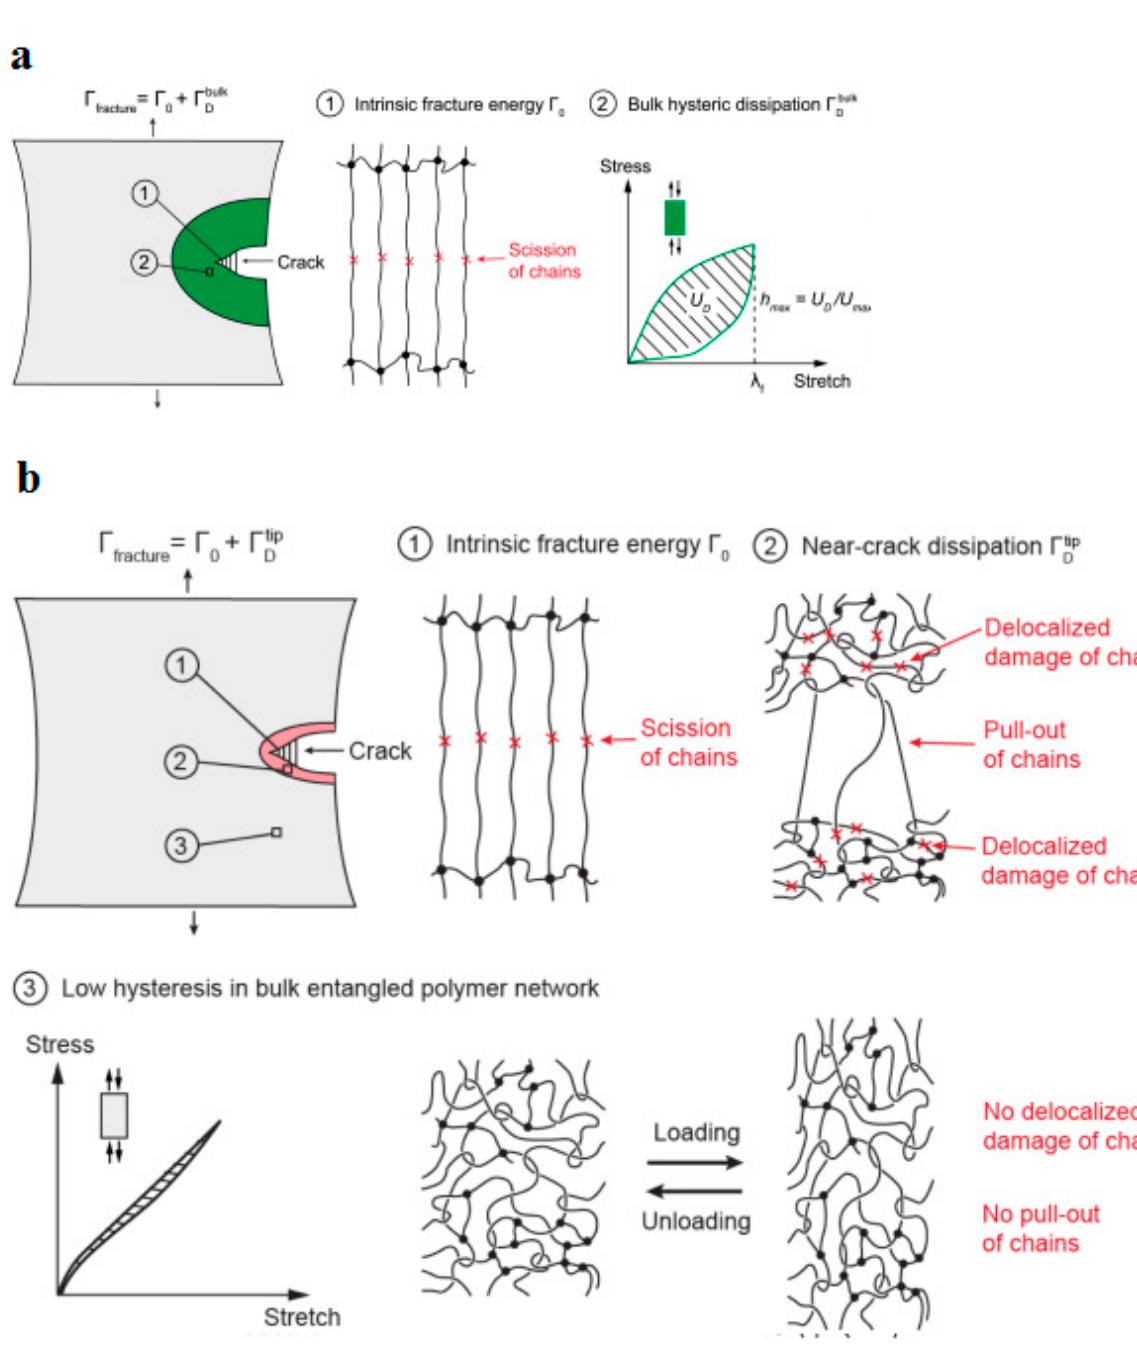
Figure 33. Schematic demonstrations of ( a ) bulk dissipation model and ( b ) the near-crack energy dissipation mechanism for entangled polymer networks, adapted with permission from Ref. [110]. Copyright © 2022 Elsevier